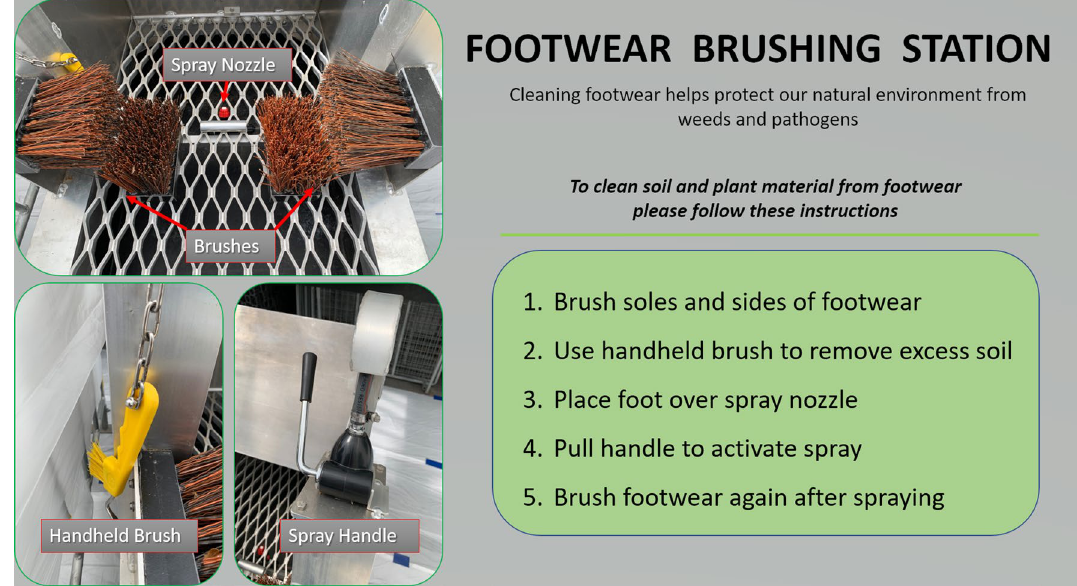
Figure 8. Hygiene station instructions shown to volunteers during the study modified from signage in a NSW national park with a similar